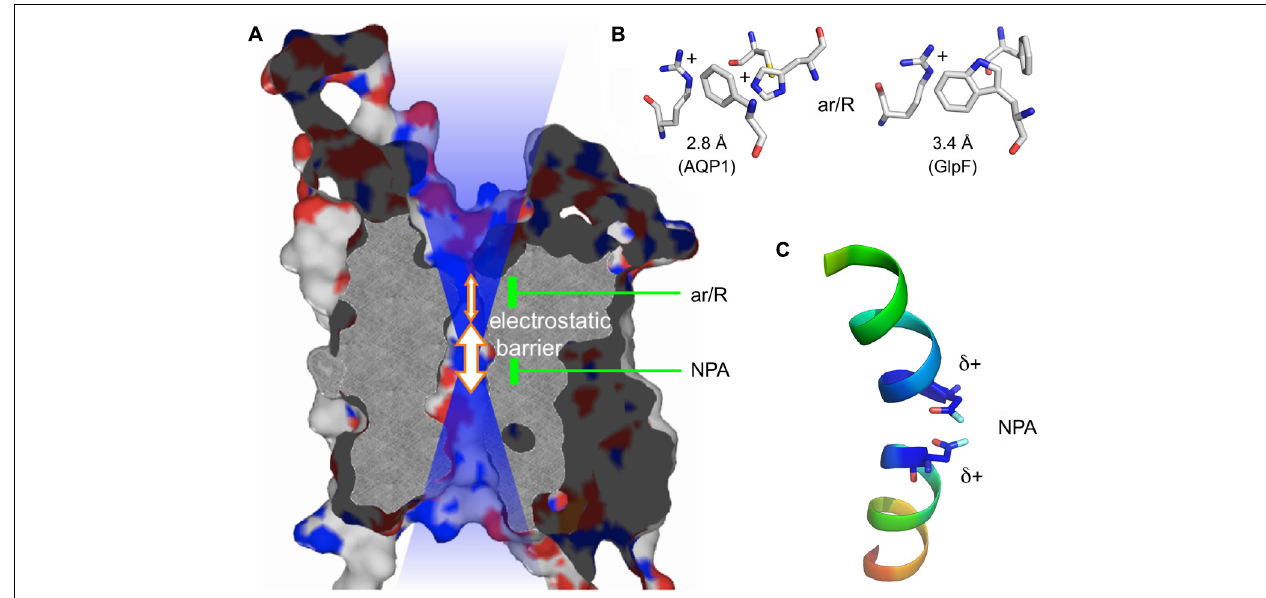
FIGURE 1 | Protein structure of anAQP monomer. (A) Slab of AQP1 showing the channel and the two constriction sites.The positive electrostatic field emanating from the channel is symbolized by the blue transparent shading. (B) Typical amino acid composition of the ar/R region in a water